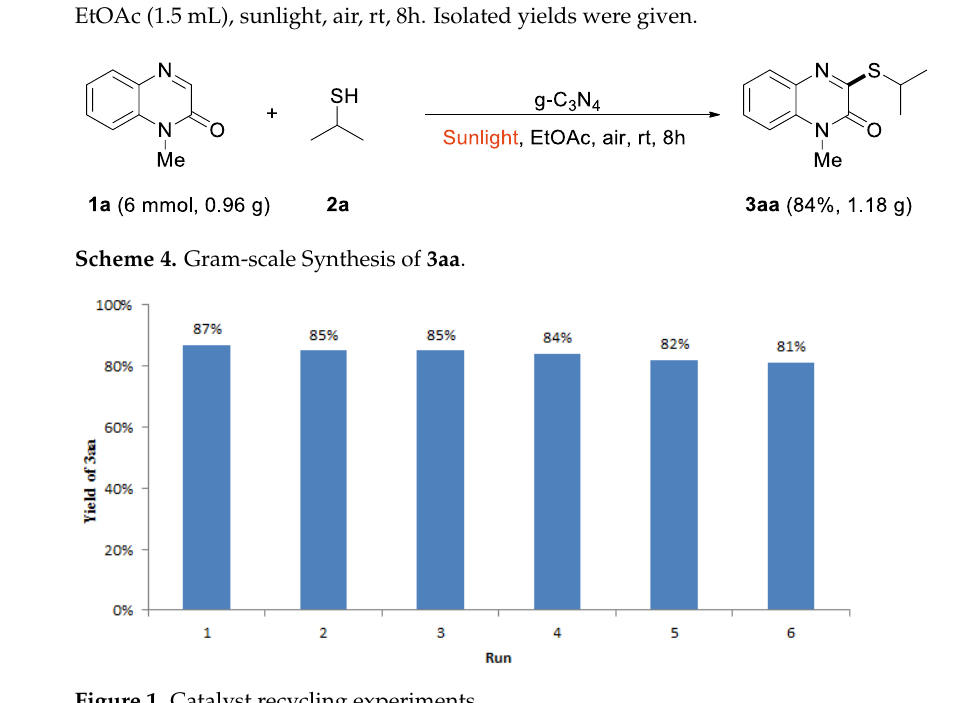
Figure 1. Catalyst recycling